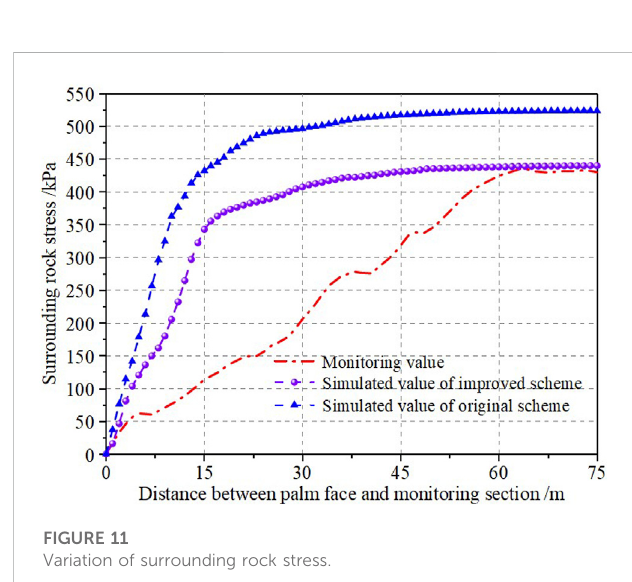
FIGURE 11 Variation of surrounding rock